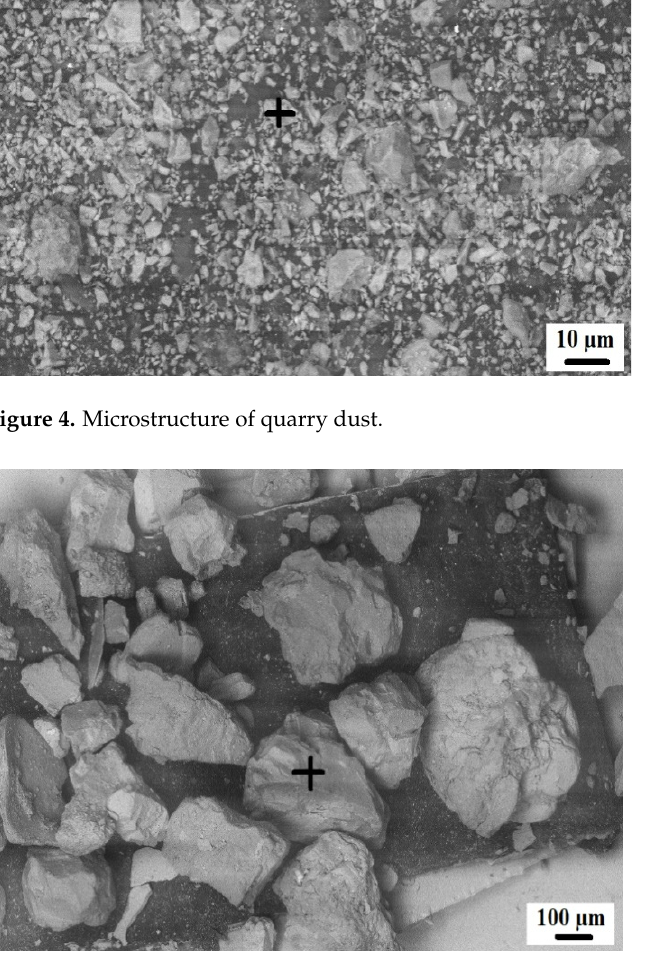
Figure 5. Microstructure of fine aggregate.